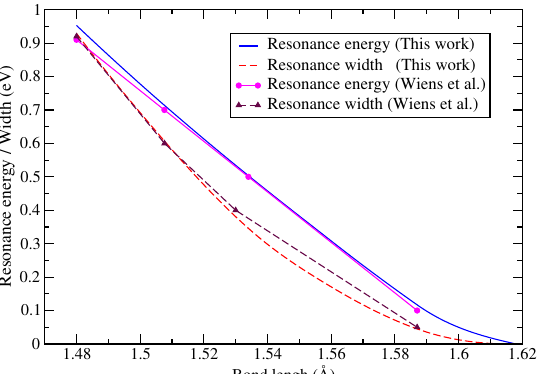
Figure 2. Resonance position and width for 12-states CC model: Resonance position—line curve; this work, line curve with circles; Wiens et al. [26]. Resonance width—dashed curve; this work, dashed curve with triangles; Wiens et al.